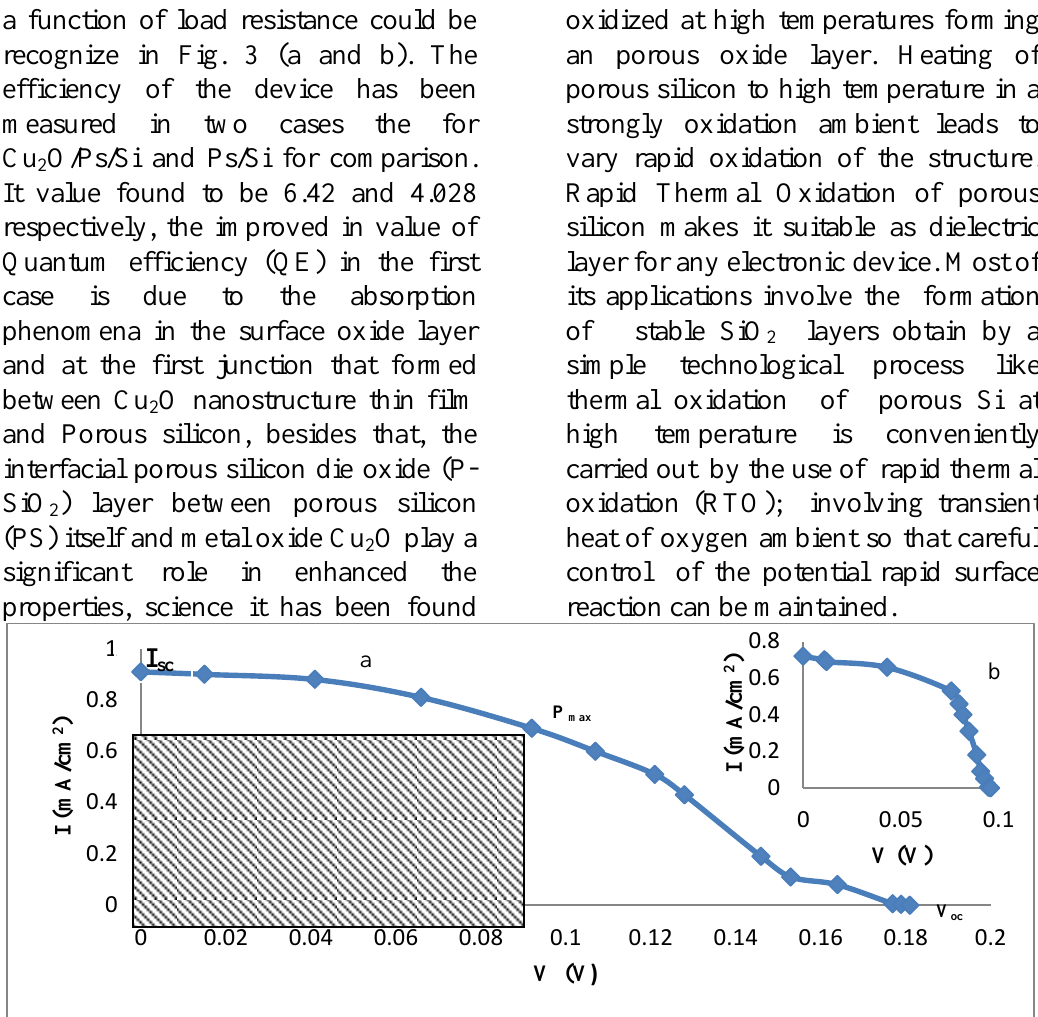
O/Ps/Si, b- Ps/Si heterojunction solar 2